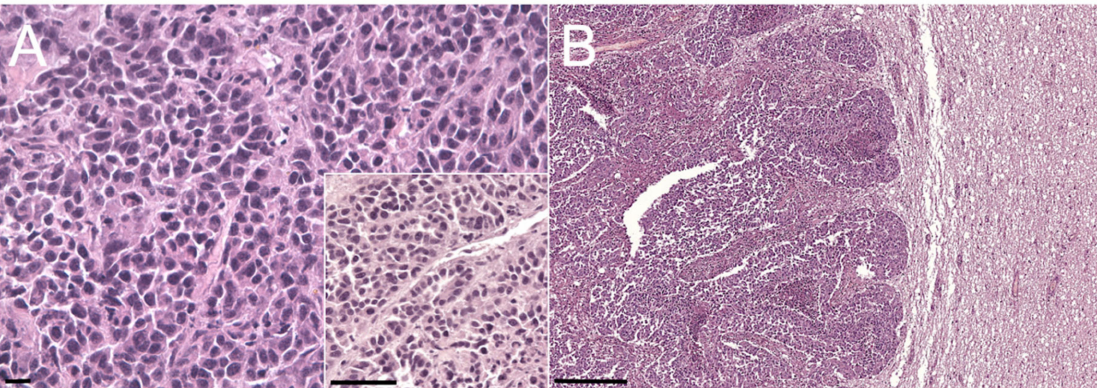
Figure 4. Photomicrographs of sections of the ocular, mammary, and cerebellar masses. ( A ) Primary mammary gland tumor. HE stain; bar = 10 µ m. Inset: detail of the tubular structure. HE stain; bar = 25 µ m. ( B ) Cerebellar metastasis. HE stain; bar = 100 µ